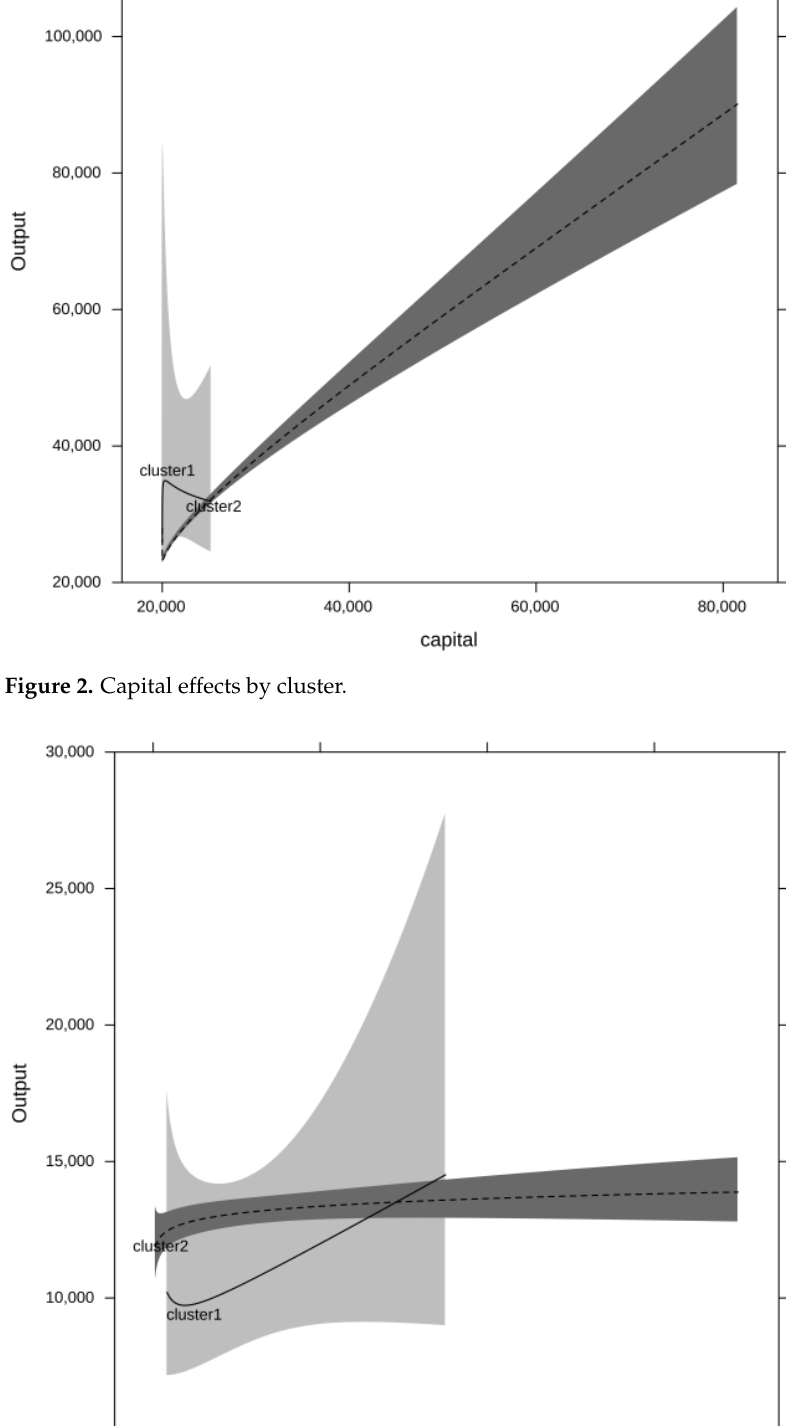
Figure 3. Labour effects by cluster.